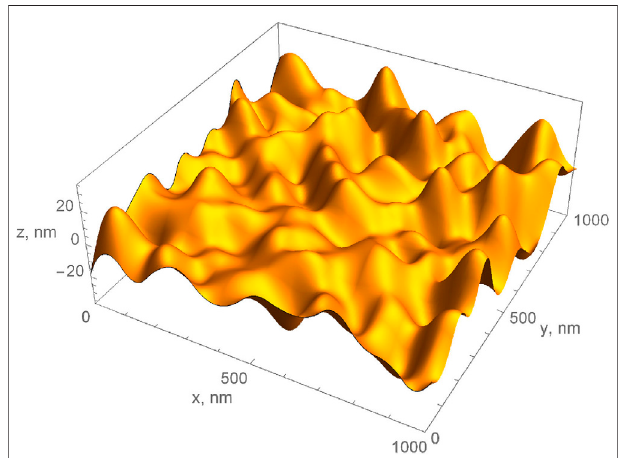
FIGURE 1 | A surface region with a correlation length of 150 nm in the distribution of inhomogeneities on an area of 1 × 1 μ m 2 .